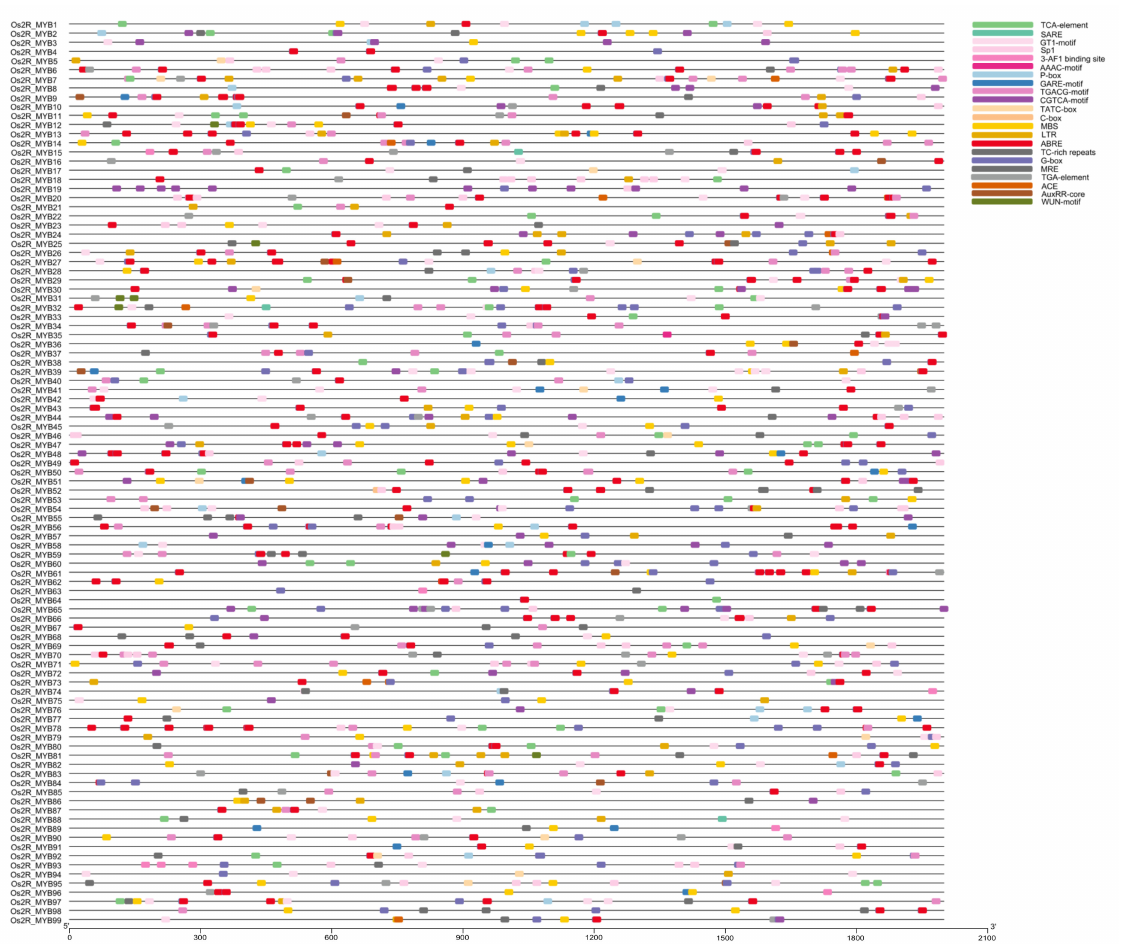
Figure 5. Distributionofcis-elementsinpromotersequencesof99 Os2R_MYB genes. TCA-element/SARE, cis-acting element involved in salicylic acid responsiveness; MBS, MYB binding site involved in drought- inducibility; GT1-motif/Sp1/3-AF1/AAAC, light-responsive element; LTR, cis-acting element involved in low-temperature responsiveness; ABRE, cis-acting element involved in the abscisic acid responsiveness; P-box/GARE, gibberellin-responsive element; TGACG/CGTCA motifs, involved in the MeJA respon- siveness; TC-rich repeats, cis-acting element involved in defense and stress responsiveness; MRE, MYB binding site involved in light responsiveness; TATC-box/C-box, cis-acting element involved in gibberellin responsiveness; TGA-element, auxin-responsive element; G-box/ACE, cis-acting element involved in light responsiveness; AuxRR-core, involved in auxin responsiveness; WUN-motif, wound-responsive